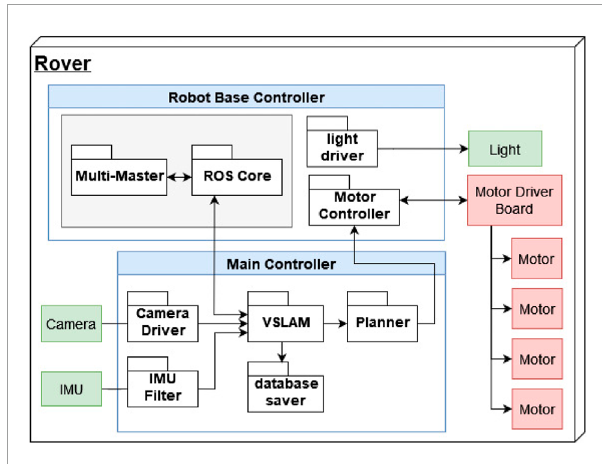
FIGURE 7 REALMS robot architecture diagram showing the robot base controller hosting the ROS Master, the hardware drivers and the main controller hosting the vSLAM system with the sensor input and the path